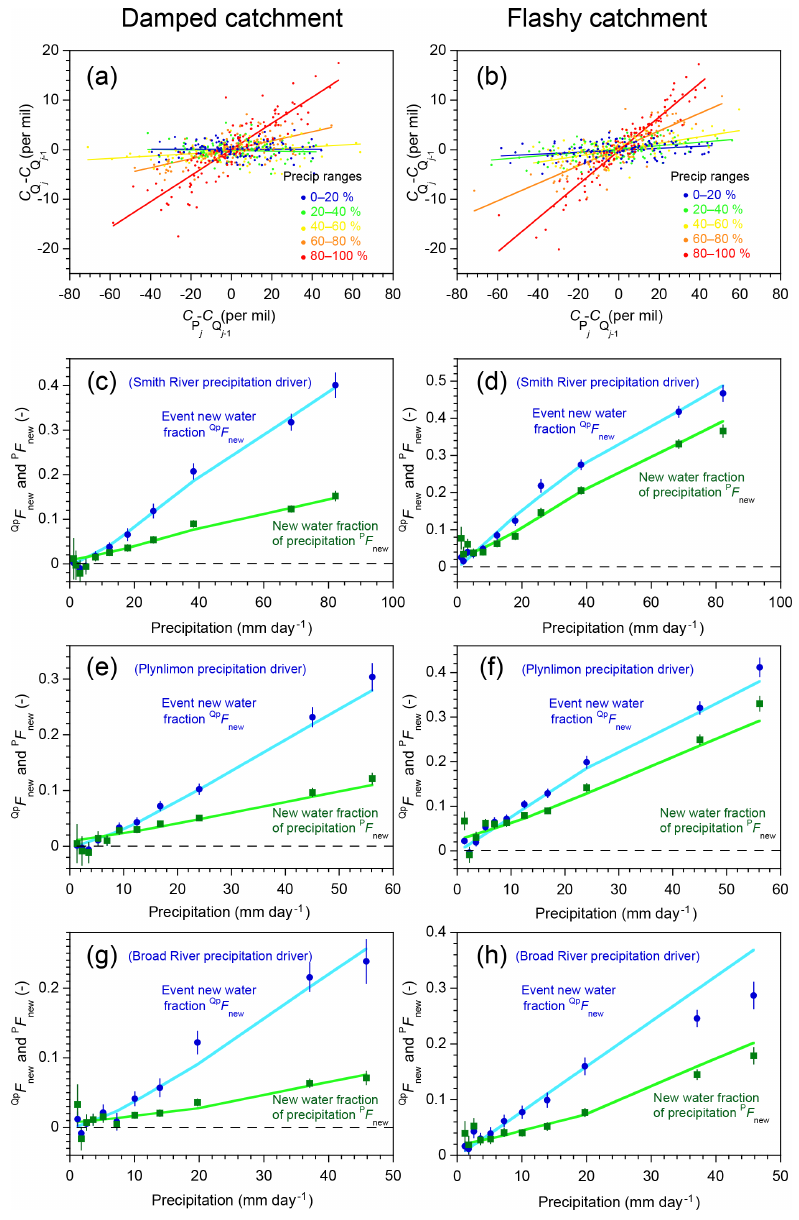
Figure 7. Variations in new water fractions across ranges of precipitation. (a, b) Relationship between tracer concentrations in precipitation and streamflow in the benchmark model run shown in Fig. 1, stratified by percentiles of the frequency distribution of precipitation, for damped and rapid response parameter sets. In these coordinates, the slope of the regression line through each ensemble of points estimates its average event new water fraction Qp F new (Eq. 10; Sect. 2.3). (c–h) Variation in new water fractions across precipitation bins in the benchmark model. Dark blue and green symbols show estimates of the event new water fraction of discharge ( Qp F new ) and the forward new water fraction ( P F new , the fraction of precipitation appearing in same-day streamflow; Eq. 21). Average Qp F new and P F new values are plotted for each decile of the daily precipitation distribution (the leftmost 10 points) and the uppermost 5% (the rightmost point), excluding precipitation amounts less than 1mmday − 1 (see text). Error bars show standard errors, where these are larger than the plotting symbols. Light blue and light green lines show the corresponding true new water fractions measured by age tracking in the benchmark model. The three rows ( c–d , e–f , and g–h ) show catchment response to three different precipitation climatologies (Smith River, Plynlimon, and Broad River), for both the damped response parameter set (c, e, g) and the flashy response parameter set (d, f, h) . The new water fractions Qp F new and P F new vary strongly with daily precipitation. Ensemble hydrograph separation accurately estimates both Q p F new and P F new across the full range of precipitation for all three forcings and both parameter